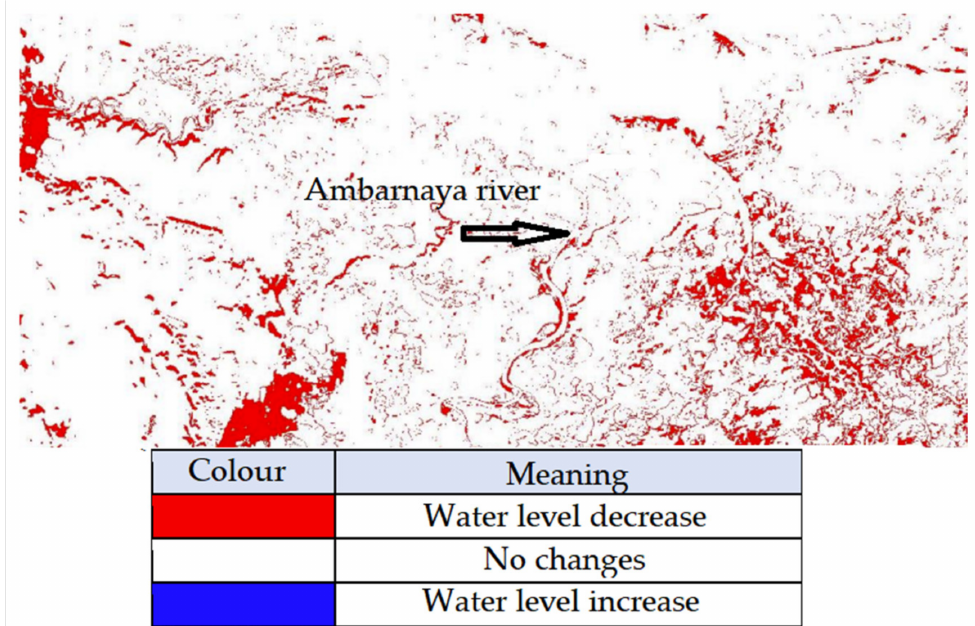
Figure 7. Water change